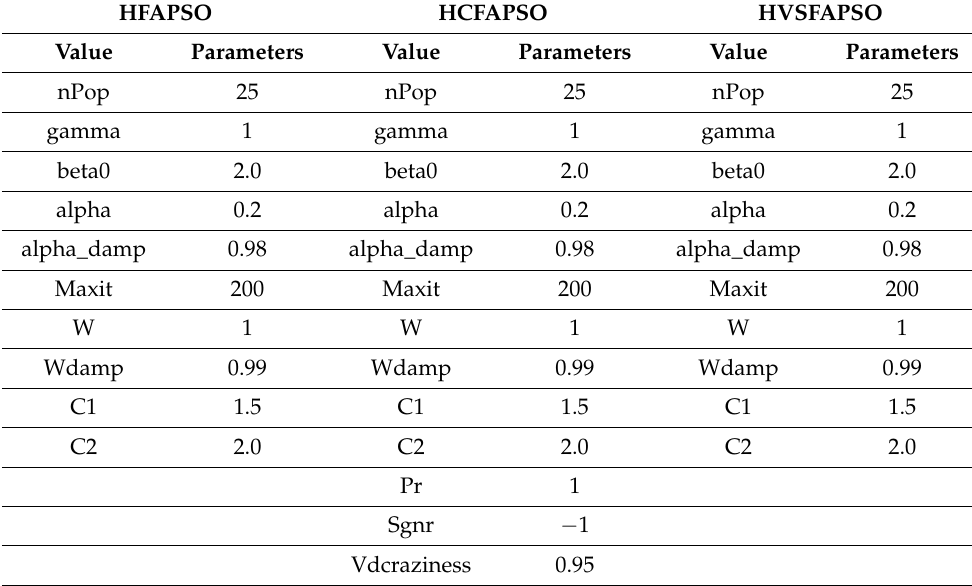
Table 1. Parameter